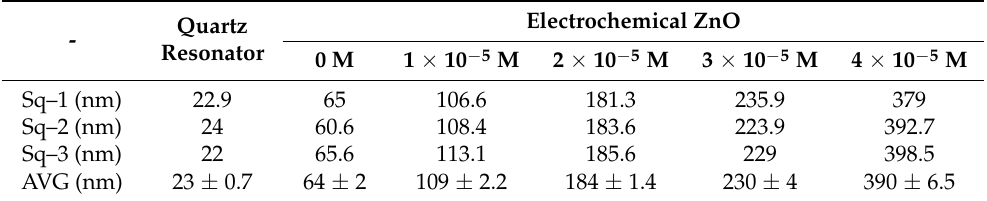
Table 1. Average roughness of the ZnO layers deposited with different concentrations of Al 2 (SO 4 ) 3 .